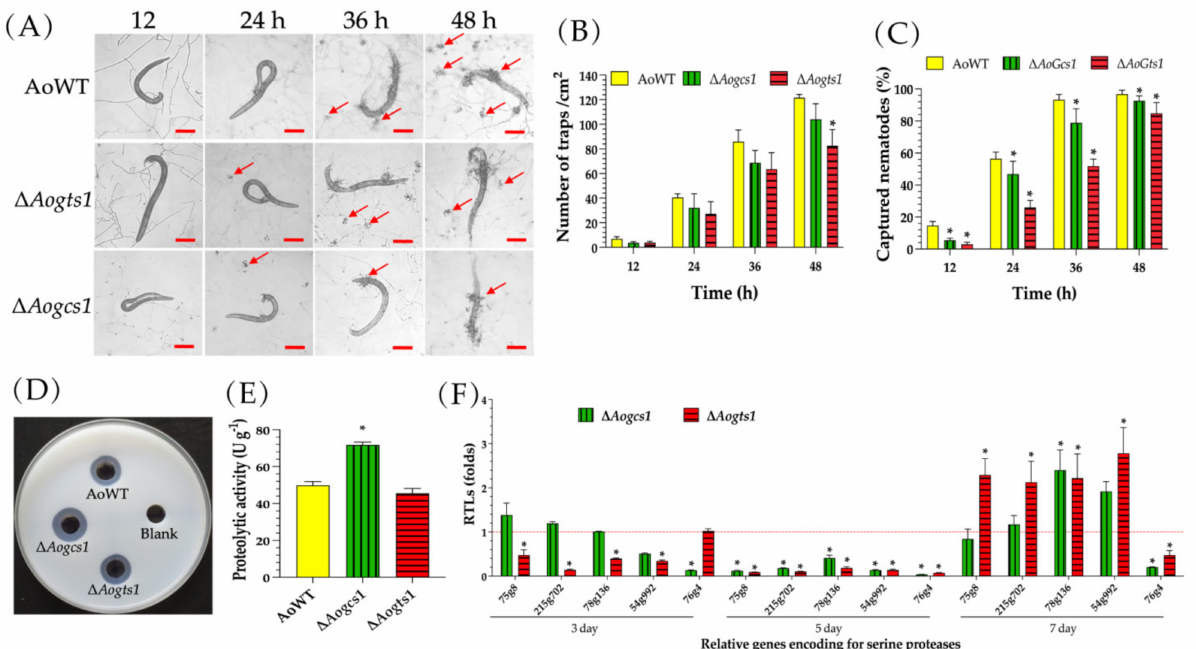
Figure 4. Comparison of trap formation, nematocidal activity, and extracellular proteolytic activity in the WT and mutant strains. ( A ) Trap formation in the WT and mutant strains induced by nematodes at different time points. The red arrows point towards the traps produced by the WT strain and mutants. Bar = 100 µ m. ( B ) The number of traps produced by the WT and mutant strains. ( C ) The percentage of captured nematodes at different time points. ( D ) Comparison of the extracellular proteolytic activities on casein plates. ( E ) Total extracellular proteolytic activity of the WT and mutant strains exhibited in 7-day old PD broth. ( F ) Relative transcription levels (RTLs) of the genes encoding serine proteases in the mutants when compared with the WT strain at different time points. The red line indicates the standard (which has an RTL of 1) for statistical analysis of the RTL of each gene in a deletion mutant compared to that in the WT strain. The asterisk indicates a significant difference between the mutants and the WT strain (Tukey’s HSD, p <